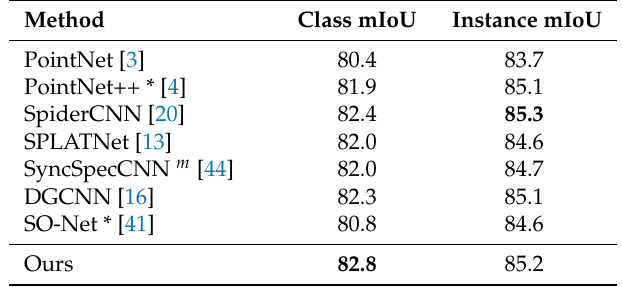
Table 5. Part segmentation results (%) on ShapeNet. Here we list the mean IoU for class and instance. (“*”: add normal vectors with points; “m”: use mesh as input). Method Class mIoU Instance